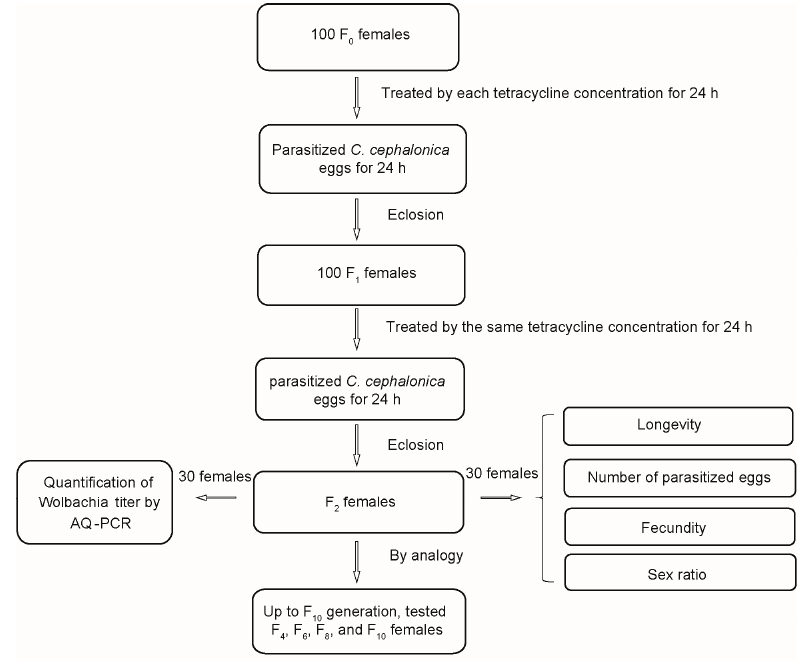
Figure 1. A flow chart of tetracycline treatment for T. pretiosum . Approximately 100 newly emerged females (<6 h old) were placed in a glass tube (2.5 × 7.5 cm) and fed with each tetracycline concentration for 24 h. An egg card with surplus C. cephalonica eggs was inserted into each tube to be parasitized for 24 h. Next, the parasi- tized egg card was labeled and maintained in the small glass tube (1.0 × 5.5 cm) until adult emergence (F 1 generation). Approximately 100 newly emerged females from the F 1 gener- ation in each concentration were placed in in a glass tube (2.5 × 7.5 cm) and fed with the same tetracycline concentration for 24 h. Then, one C. cephalonica egg card was offered and parasitized for 24 h in each treatment, and the parasitized egg sheets were maintained in a growth chamber until adult emergence (F 2 generation). The newly emerged F 2 females (<6 h old) were divided into three assays. (1) The first assay was carried out to evaluate the sublethal effects of tetracycline on the parasitoid. The details are as follows: 30 females from the F 2 generation in each concentration were placed individually into membrane-forming glass dactylethrae (2.3 × 7.4 cm) with a superfluous C. cephalonica eggs card and supplied with 25% honey–water solution. The parasitized egg cards were renewed every 24 h until the female died. All the parasitized egg cards were incubated in a growth chamber until adult emergence. The longevity, par- asitism capacity, and the fecundity (number of offspring produced per female) of the fe- males were assessed. The sex ratio (SR) of offspring was also recorded for all the emerged adults. Based on the adults’ antennae characteristics [6,25], SR was calculated using the formulas: SR (% female) = [number of females/(number of females + number of males + number of intersex)] × 100; SR (% male) = [number of males/(number of females + number of males + number of intersex)] × 100; SR (% intersex) = [number of intersex/(number of females + number of males + number of intersex)] × 100. (2) The second assay was conducted to detect the Wolbachia titer using AQ-RCR (see quantification of Wolbachia below for details).